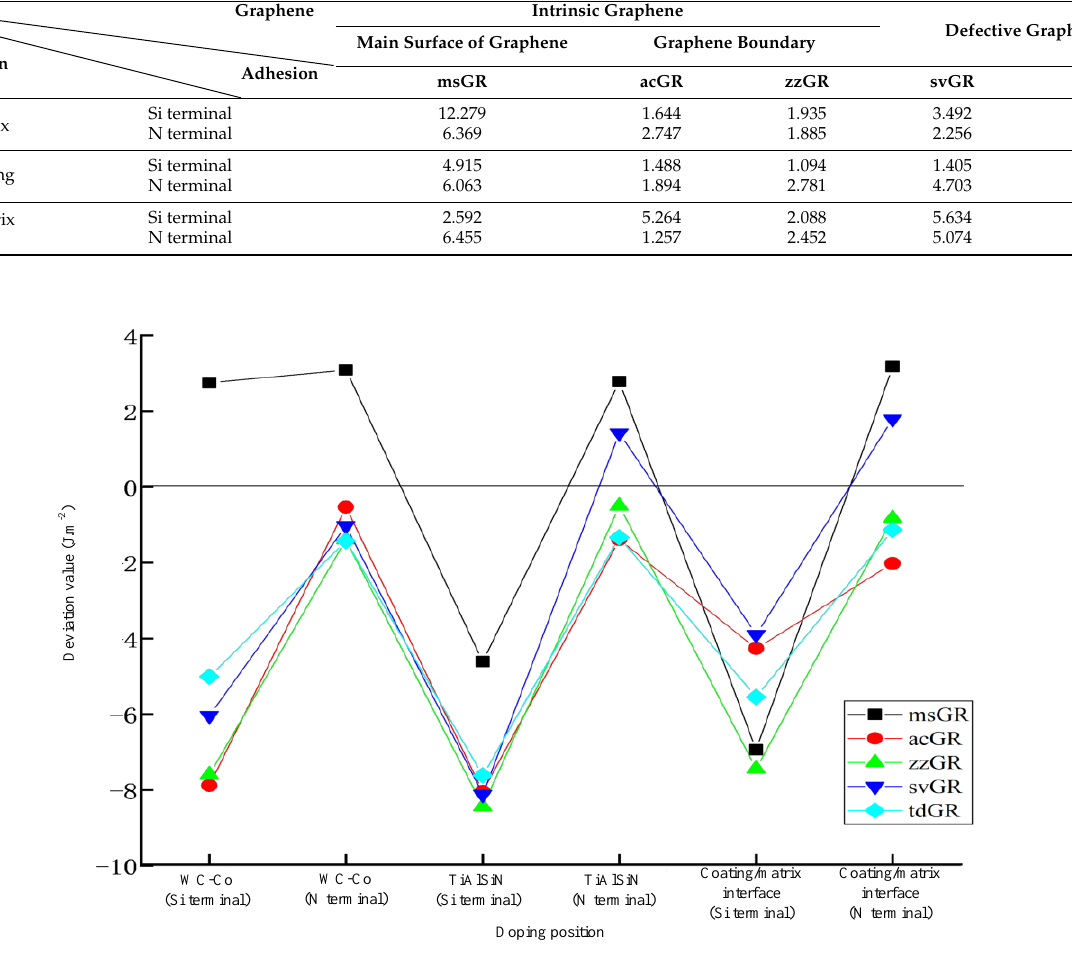
Figure 8. Deviation between adhesion work of graphene-doped TiAlSiN/WC-Co and that of TiAlSiN/WC-Co without graphene doping.